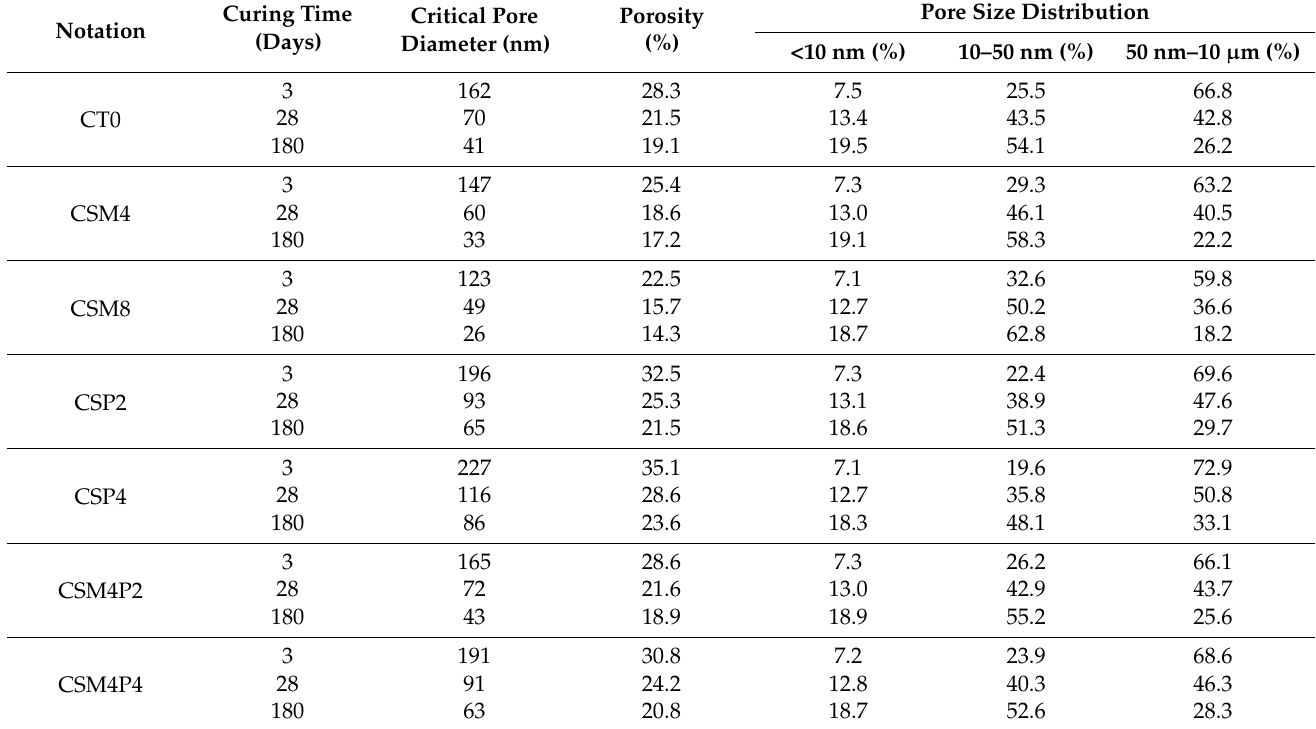
Table 7. Pore structures of hydraulic concretes containing MgO and/or PVA